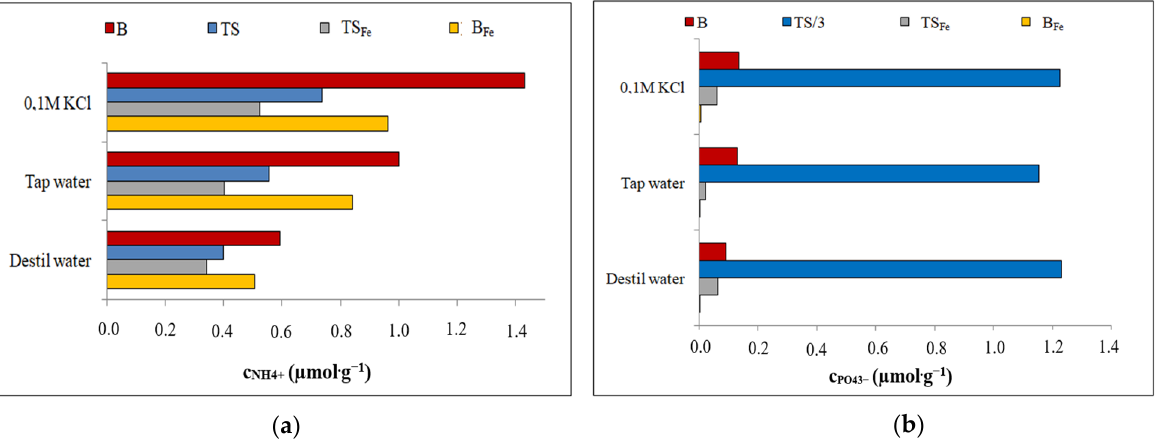
Figure 6. The amount of ion leached from B/B Fe and TS/TS Fe before adsorption: ( a ) NH 4+ ; ( b ) PO 43 − .